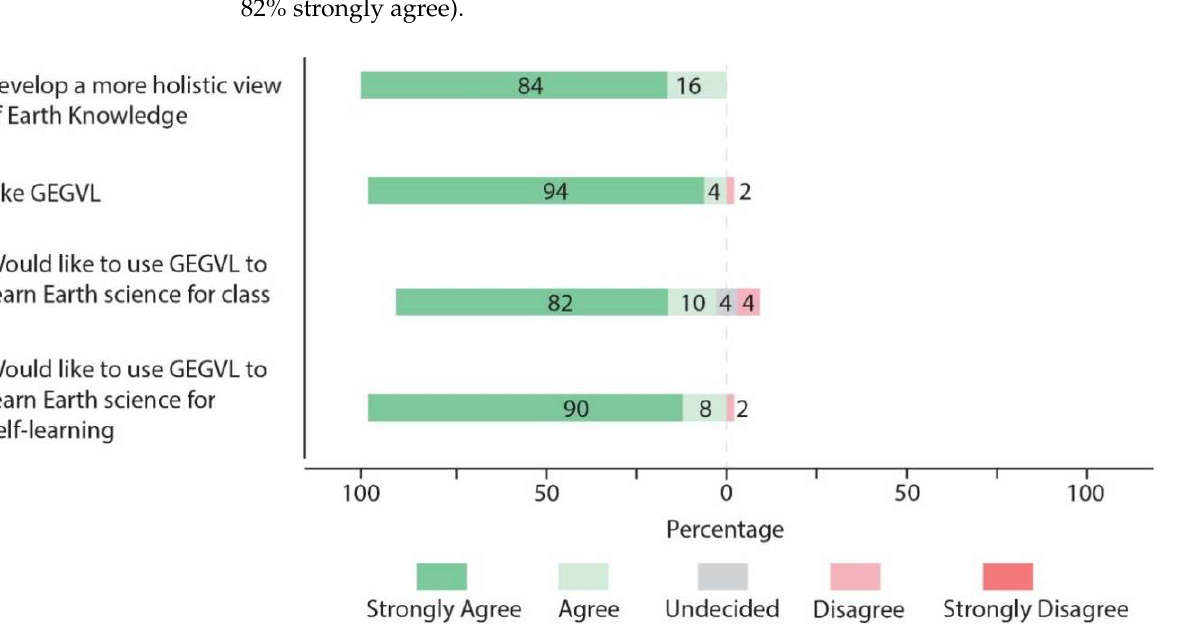
Figure 4. Responses to the GEGVL experience survey.